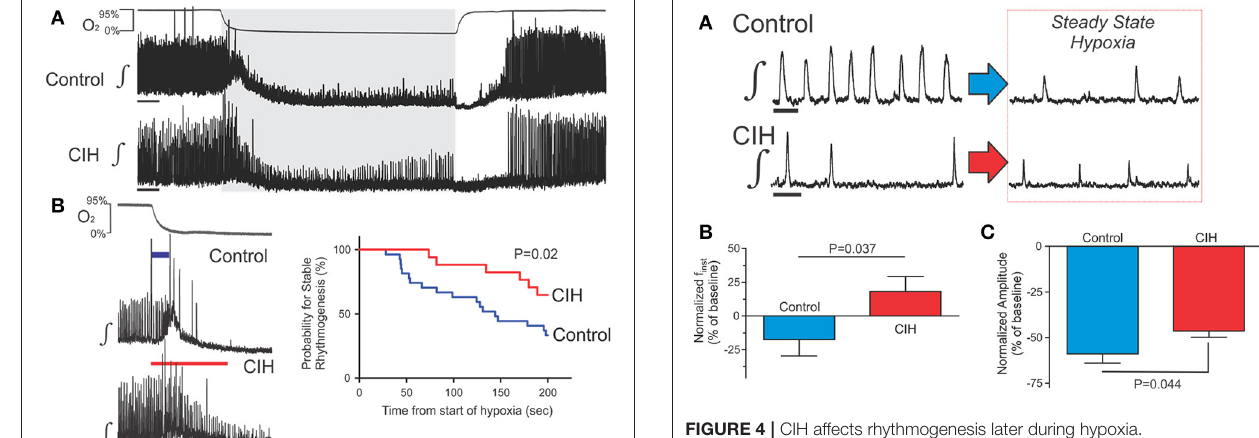
the transition to hypoxia (i.e., the first 200 s of exposure),